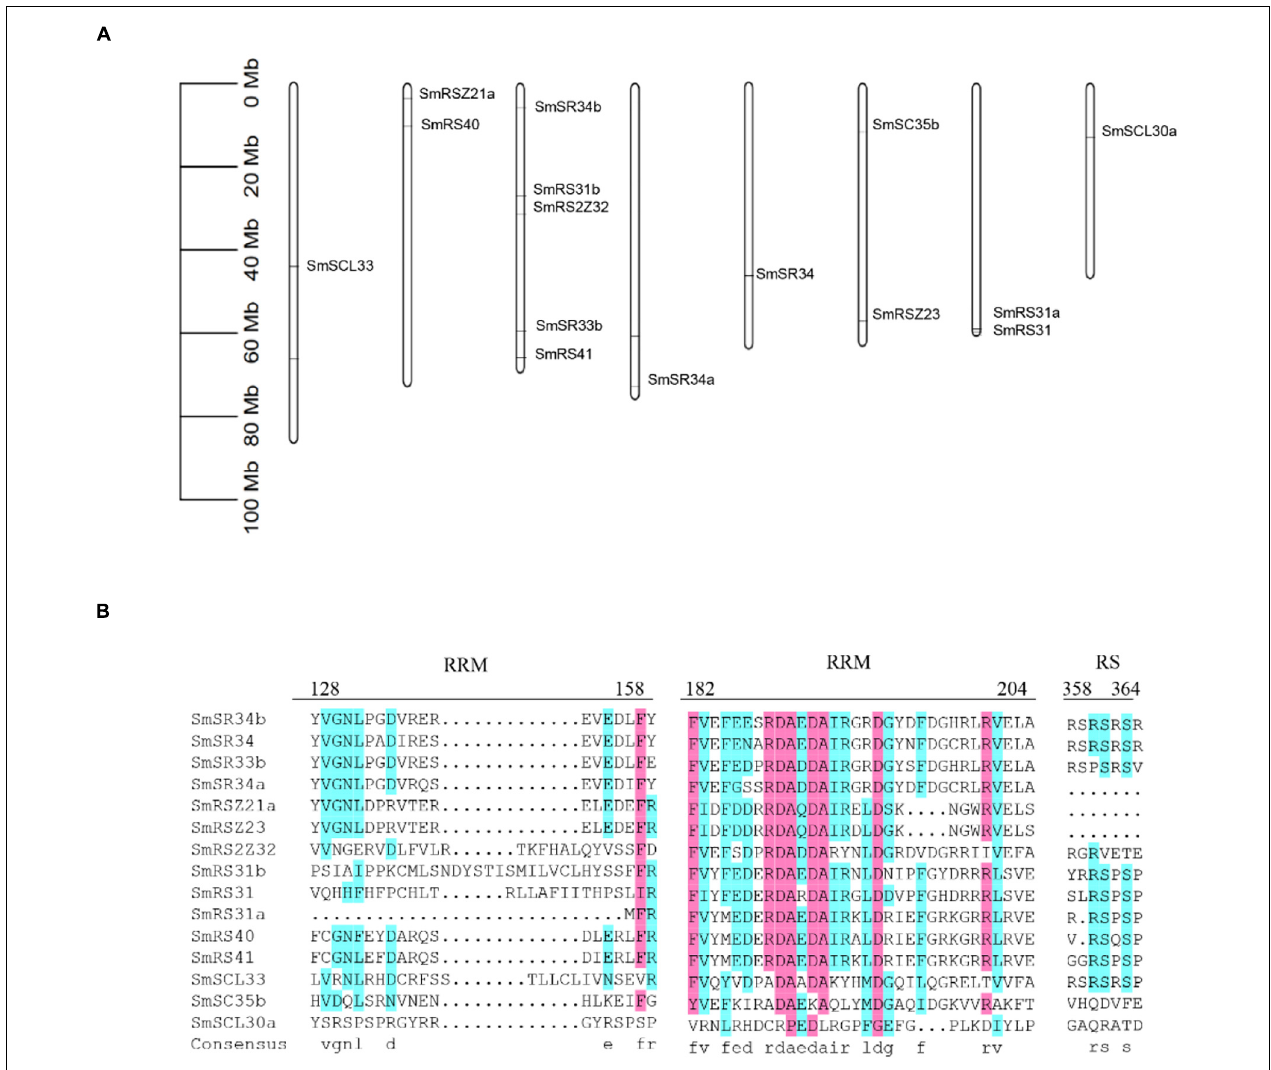
FIGURE 6 | Chromosomal distribution and multiple sequence alignment of SR proteins. (A) Chromosomal distribution of SR proteins coding genes. (B) Multiple sequence alignment was obtained by the DNAMAN software. The family-specific conserved motifs were